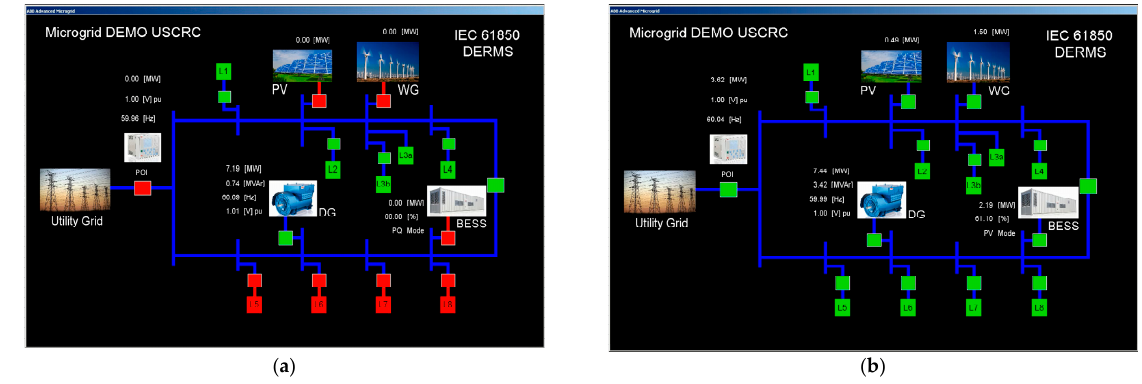
Figure 6. Human machine interface (HMI) prototype: ( a ) Islanded microgrid, ( b ) Grid connected microgrid